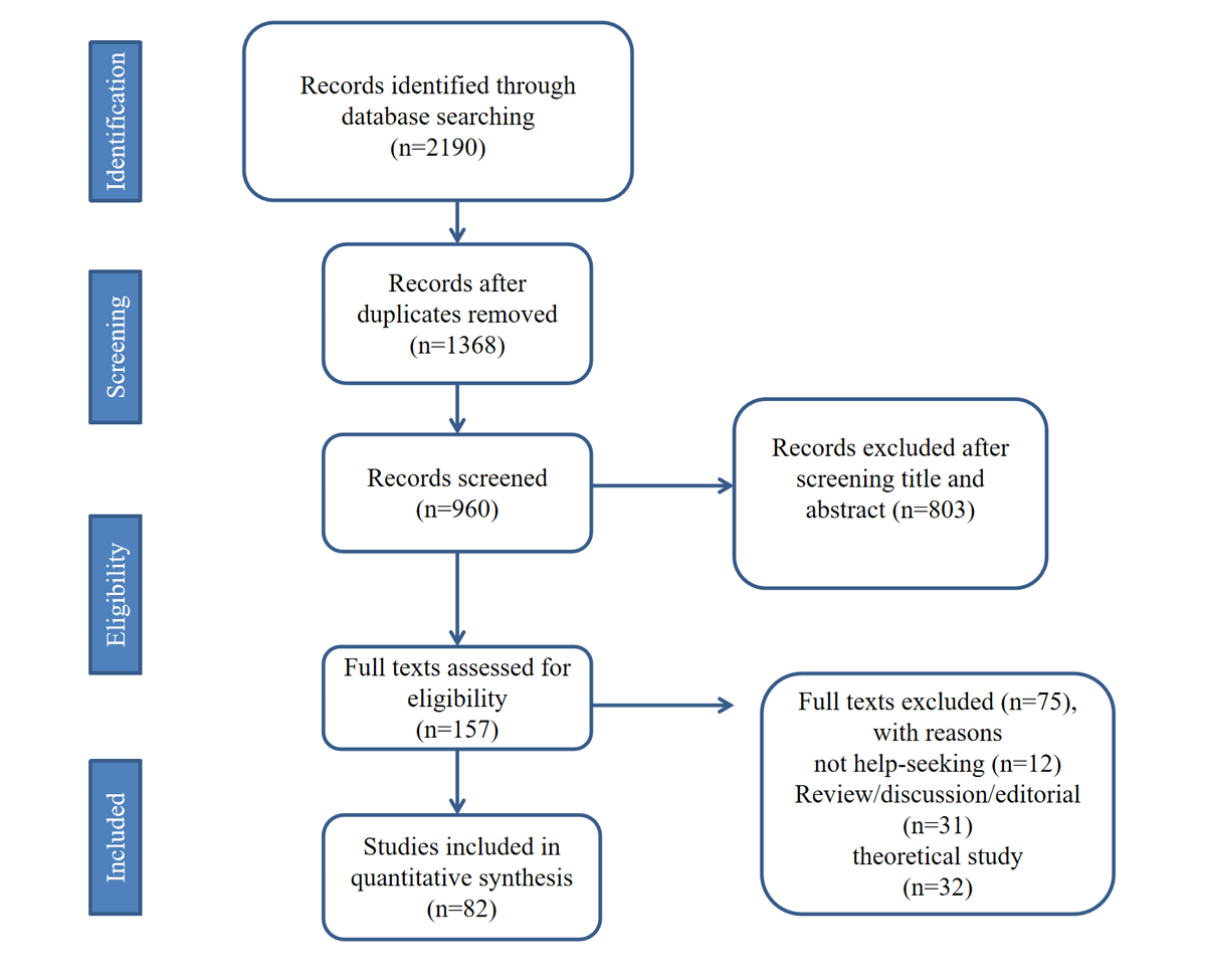
Figure 1. The flow diagram illustrating the screening process of